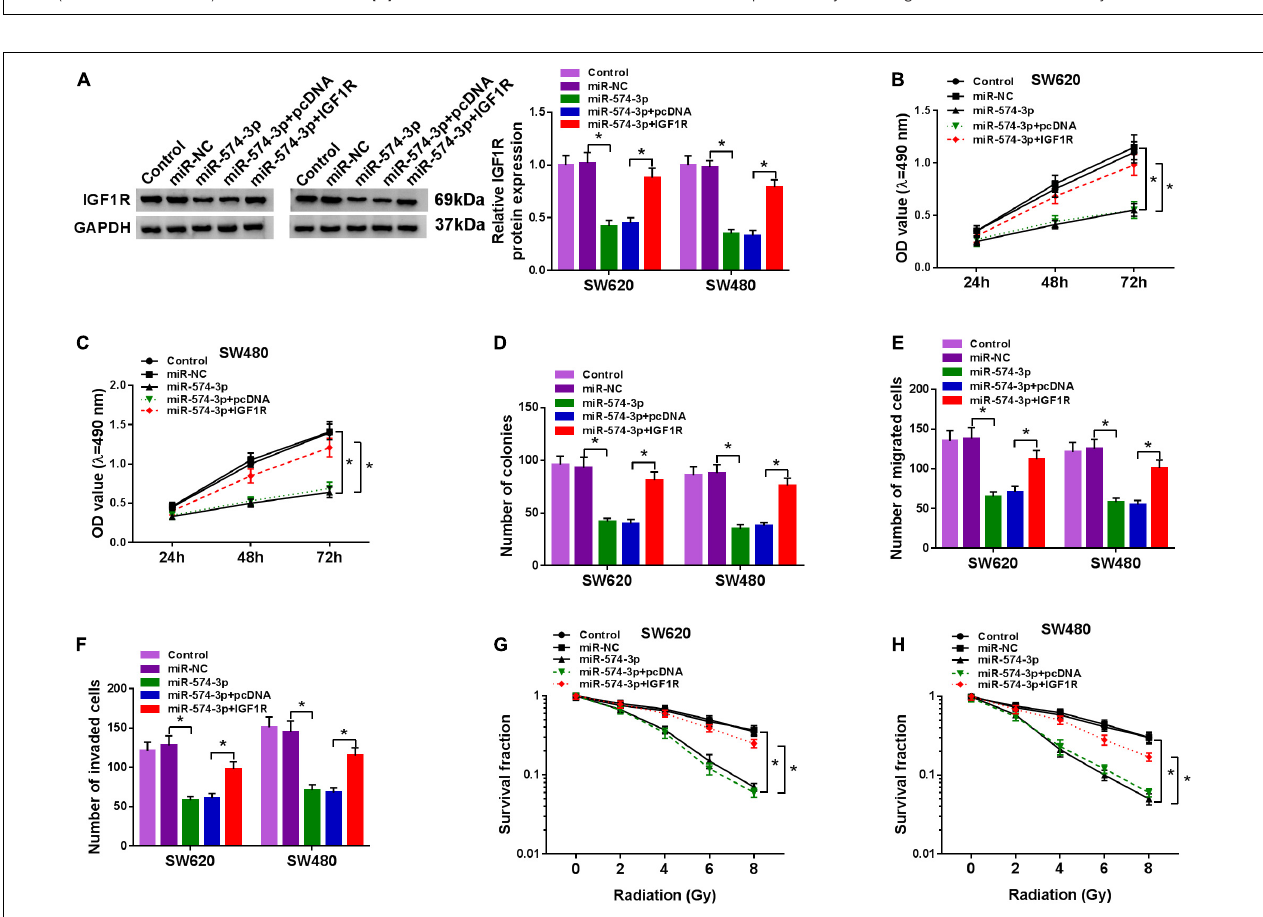
FIGURE 7 | The regulation of miR-574-3p mimic and IGF1R overexpression on CRC progression. SW620 and SW480 cells were transfected with miR-NC, miR-574-3p, miR-574-3p + pcDNA or miR-574-3p + IGF1R, and non-transfected cells were used as control. (A) The protein level of IGF1R was measured by WB analysis to evaluate transfection efficiency. (B,C) The viability of cells was assessed using MTT assay. (D) Colony formation assay was determined to evaluate the number of colonies. (E,F) The migration and invasion of cells were detected using transwell assay. (G,H) The survival fraction of cells was examined using colony formation assay. * P <